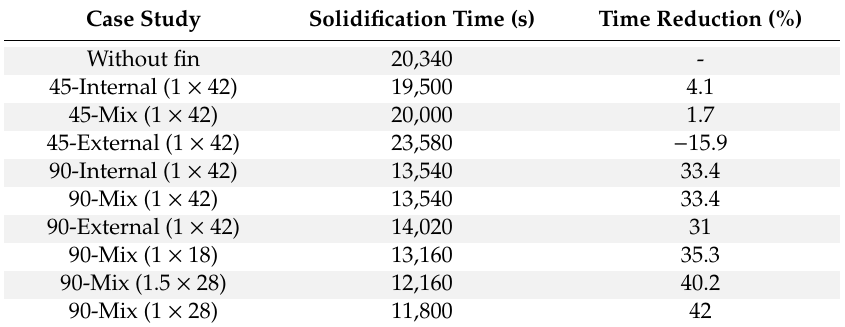
Table 3. The required time for the complete solidification and the time reduction percentage for all cases.